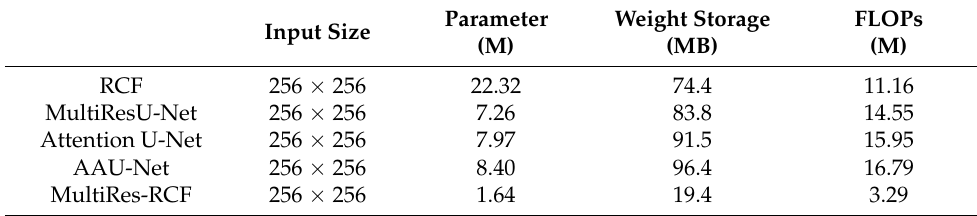
Table 1. The parameters and storage consumption of the models.